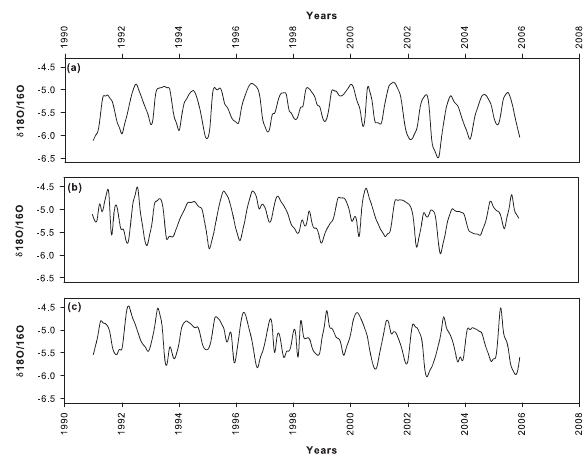
Fig. A2. The skeletal δ 18 O time-series of coral cores MAS1 (a) , ANDRA (b) and IFAHO (c) for the common period